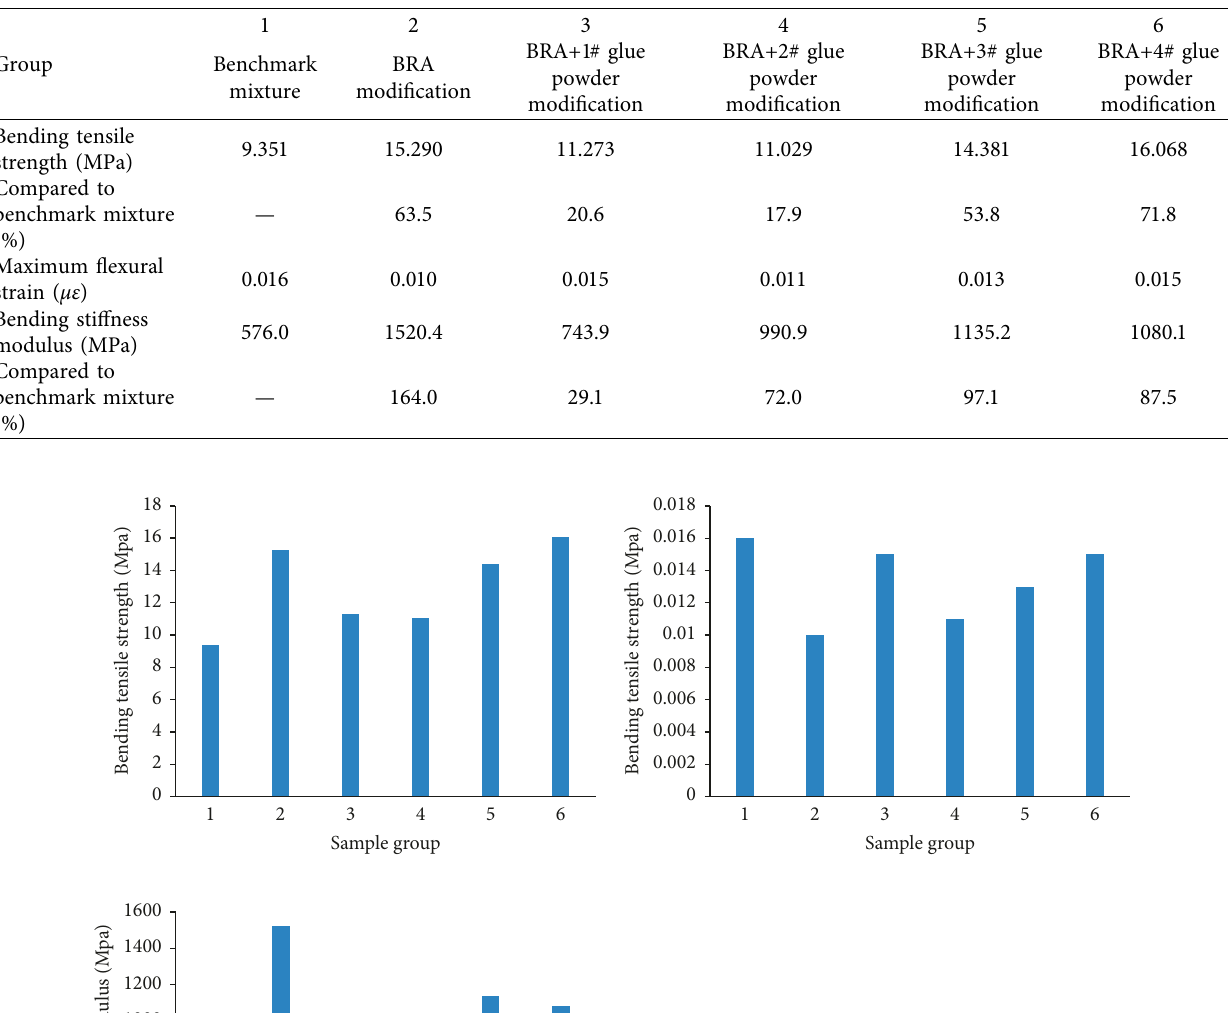
Table 8: Bending test results.